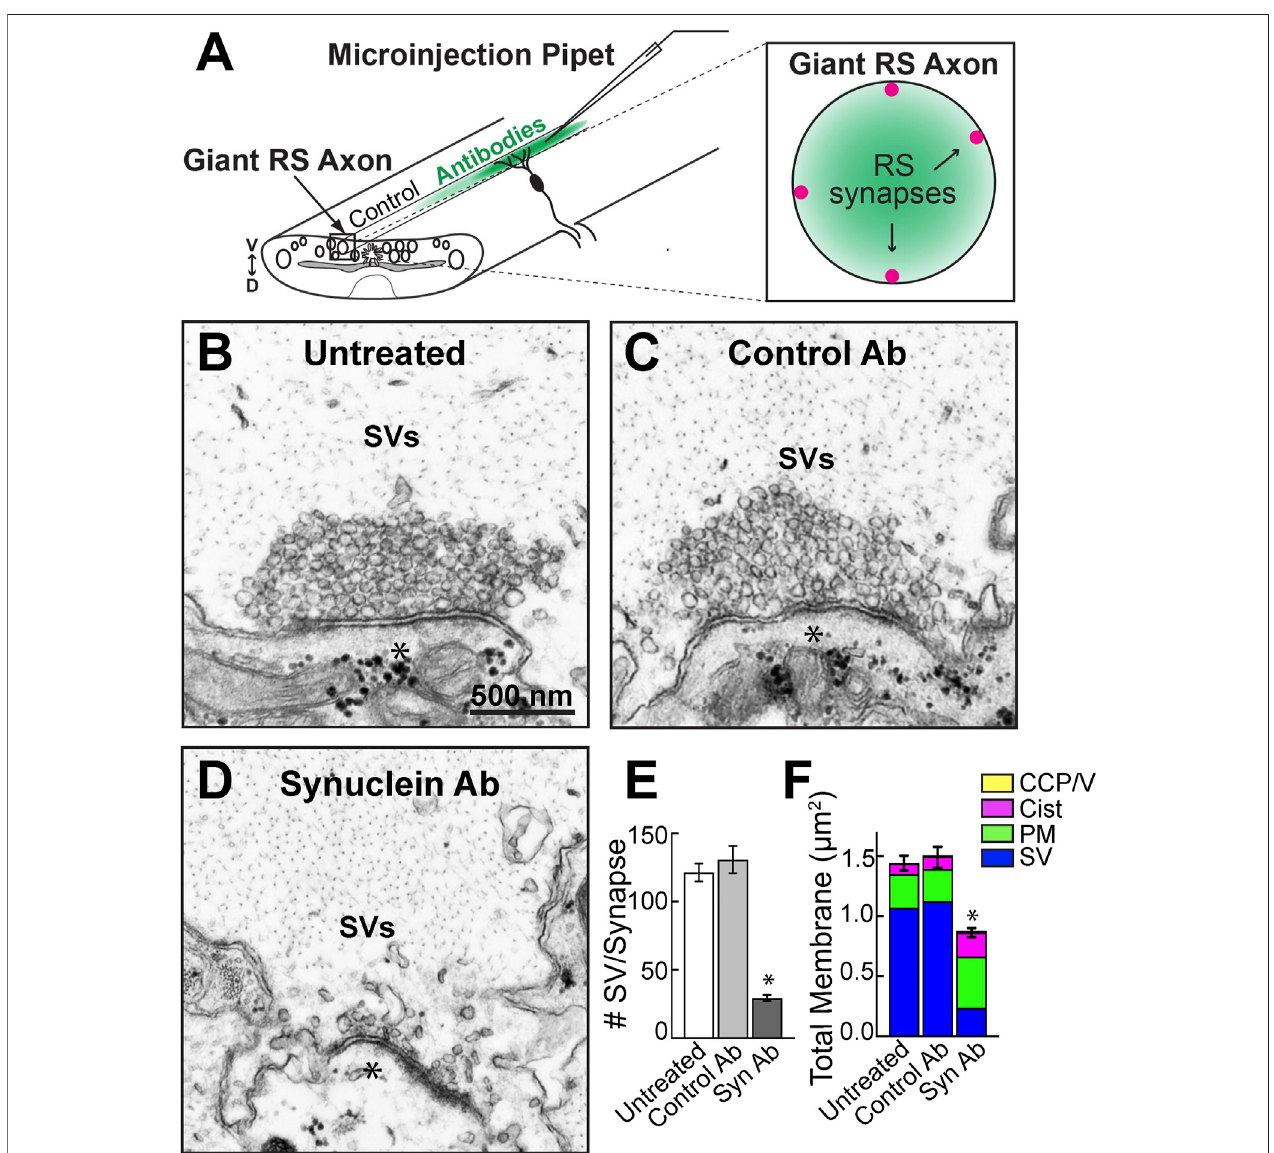
FIGURE2| Microinjectionofapan-synucleinantibodyinducedaseveredepletionofsynapticvesiclesatrestinglampreysynapses. (A) Diagramshowingacuteperturbation strategy.AntibodiesareinjecteddirectlyintothegiantRSaxons (left), whichdeliversthereagentsdirectlytothesynapticvesicleclustersatrestingRSsynapses (right). Notethe concentration gradient of injected antibodies, which permits evaluation of dose-dependent effects. (B – D) Electron micrographs ofgiant RS synapses. Atuntreated synapses, or after injection with Control IgG antibodies (Ab), the synaptic vesicle (SV) clusters are large and tightly clustered. After treatment with the Synuclein Ab, the SV clusters were severelydepleted.Asterisksmarkpostsynapticdendrites.ScalebarinBis500 nmandappliesto C – D . (E) Comparedtocontrols,thesynucleinantibodyreducedthenumberof SVs in the vesicle cluster by > 75%. Data are plotted asmean/section/synapse. (F) Thesynuclein antibody also signi fi cantly reduced the totalamountofmembrane at